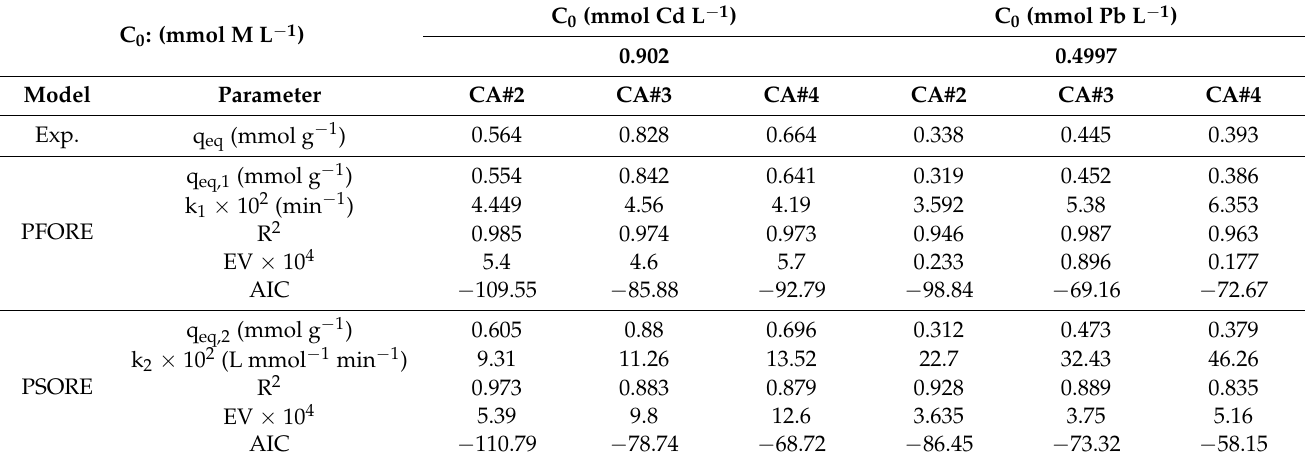
Table 1. Parameters of the kinetic models for Cd(II) and Pb(II) of using